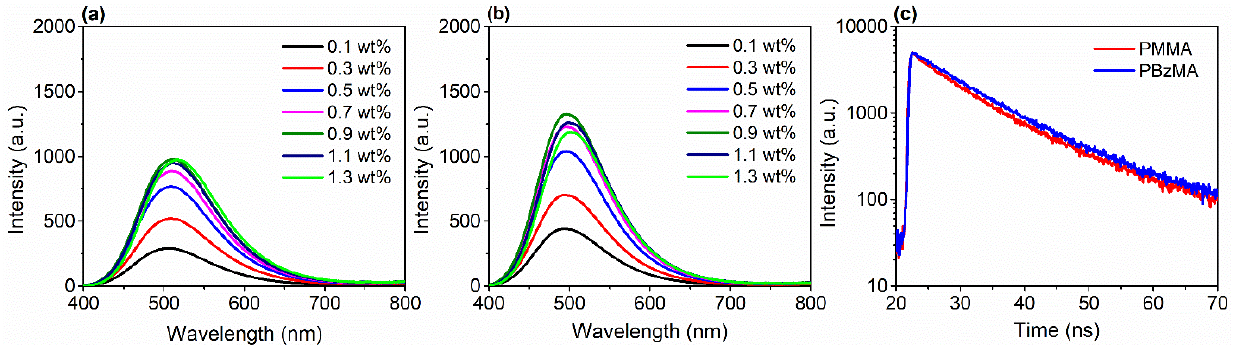
Figure 3. Emission spectra of DACT-II in ( a ) PMMA and ( b ) PBzMA films at the excitation wavelength of 350 nm. ( c ) Time- resolved photoluminescence spectra of DACT-II in PMMA and PBzMA films.